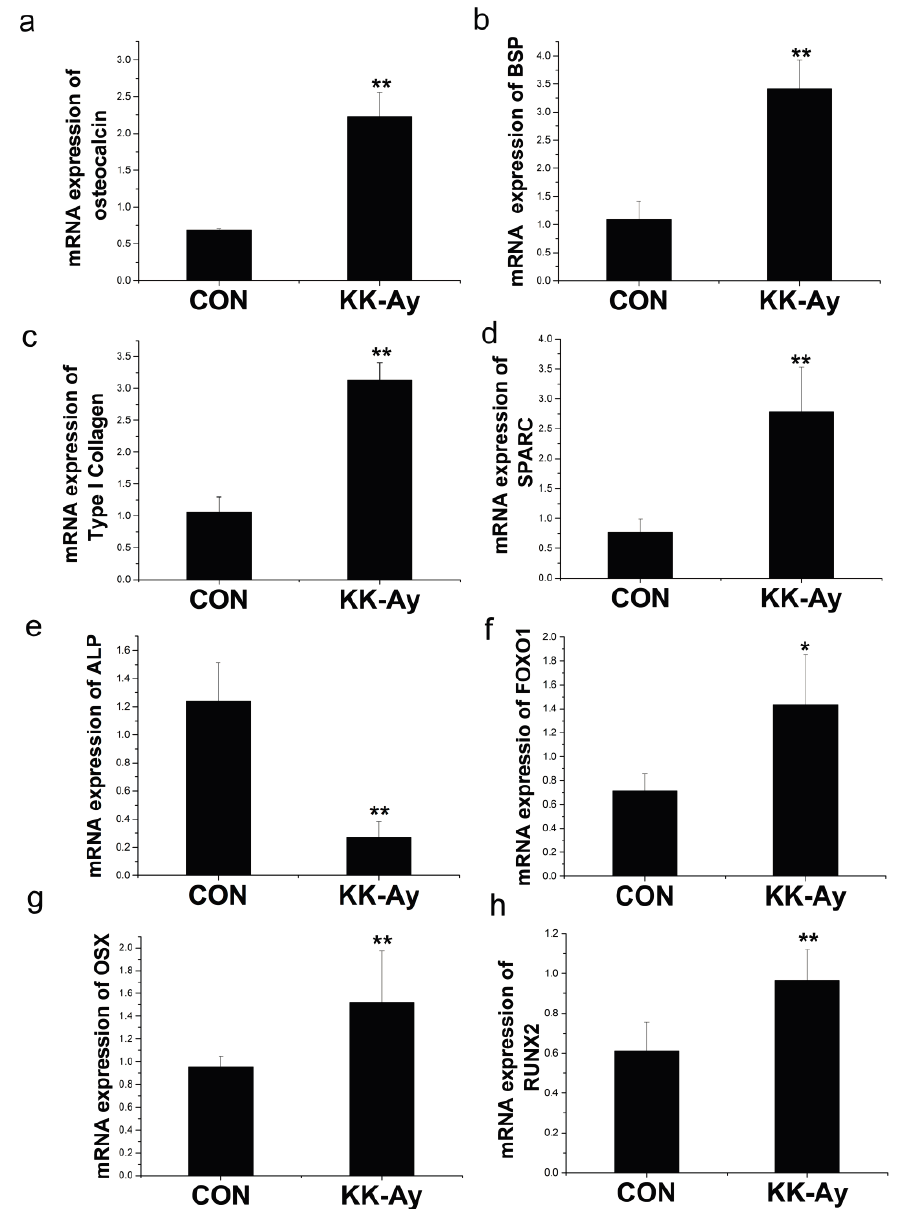
Figure 5. The expression of osteoblast-related genes in control (CON) and KK-Ay diabetic mice RNA was extracted from the bone of control and KK-Ay mice, reverse transcribed, and subjected to real-time PCR analysis. ( a ) mRNA expression of osteocalcin; ( b ) mRNA expression of bone sialoprotein ( BSP ); ( c ) mRNA expression of Type I Collagen; ( d ) mRNA expression of osteonectin; ( e ) mRNA expression of alkaline phosphatase( ALP ); ( f ) mRNA expression of FOXO1 ; ( g ) mRNA expression of OSX ; ( h ) mRNA expression of RUNX2 ; n = 5–8, ** p < 0.01 vs. CON; * p < 0.05 vs. CON. The data are shown as the means ± SE. 2.6.2. Enhanced Osteoclast-Related Gene Expression in KK-Ay Diabetic